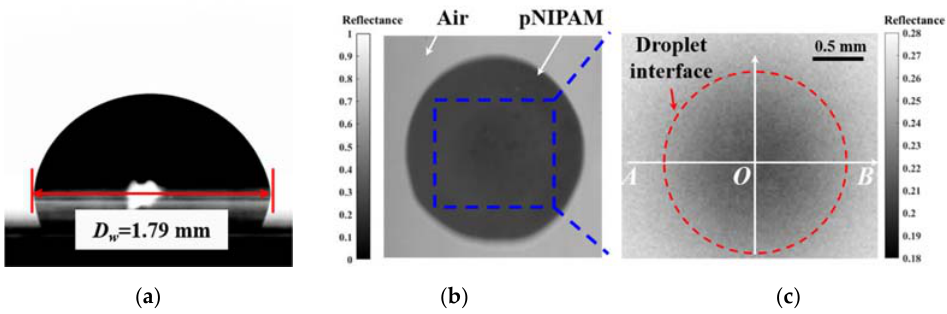
Figure 5. ( a ) Side view of a de-ionized (DI) water droplet, ( b ) SPRi image after locating a droplet at t = 0 s and T s = 29.0 ◦ C, and ( c ) magnified image of reflectance of blue dotted rectangular region. Temperature distributions over a pNIPAM solution are estimated through the reflectance obtained by the corresponding SPR intensity. Figure 6a shows the reflectance of the pNIPAM solution along with line AB (in Figure 5c) right after a droplet deposition. The initial reflectance of the pNIPAM solution before the droplet deposition is about 0.1746, 0.2106, and 0.2680 for the surface temperature, T s , of 27.0, 28.0, and 29.0 ◦ C, respectively. A DI-water is located at − 895 µ m to 895 µ m with a diameter of 1790 µ m; a minimum reflectance is observed near the center ( r = 0 µ m) for all cases. Reflectance varies relatively large for the surface temperature of 29.0 ◦ C. However, other cases have a small change of reflectance at the location of the droplet because the refractive index of the pNIPAM solution drastically deviates with the increase of the temperature, as in Figure 3b. The temperature of the pNIPAM solution, T 1,p , is obtained by using Equations (2) and (3). A measurable temperature range is 24.3 ◦ C through 29.3 ◦ C considering the thermo-sensitivity